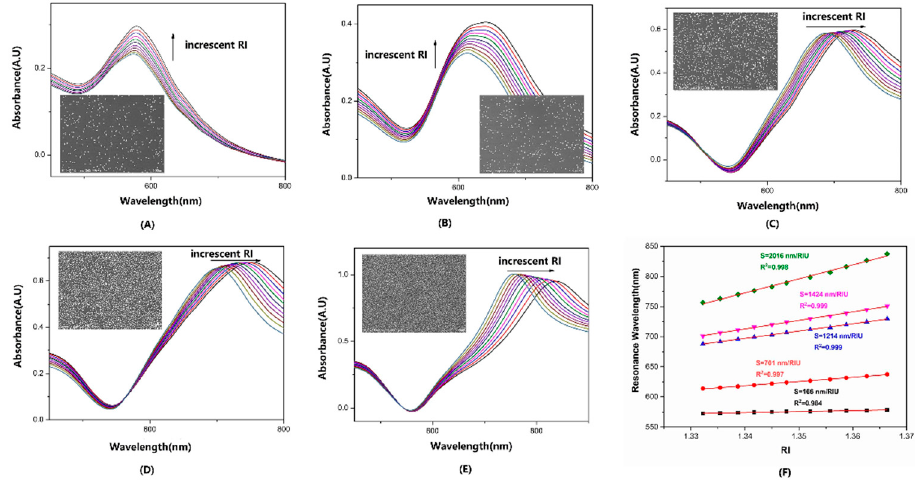
Figure 4. The absorbance spectrum series in glycerol solutions of fiber sensors immersed into 80 nm AuNS colloid for ( A – E ) 2, 5, 15, 30, and 60 min. ( F ) The S RI and R-squared of fiber sensors with different AuNS densities.